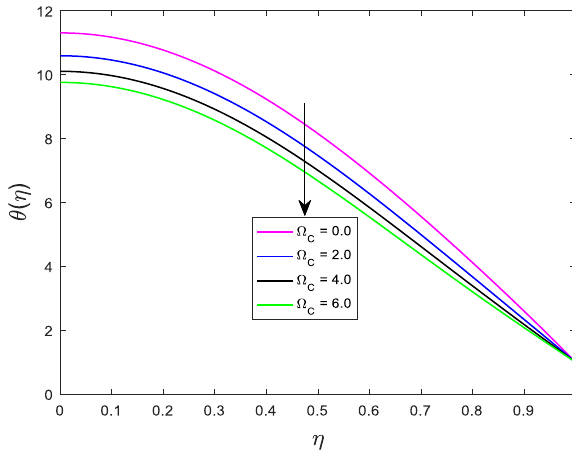
Figure 16: Effect of Ω C on θ ( η ) for fixed S = 1.5, Ω T = N b = 0.5, β = Ha = 0.1, N = −0.1, Ec = 0.1, Pr = 0.7, Kr = t −0.5 and Sc = 0.7